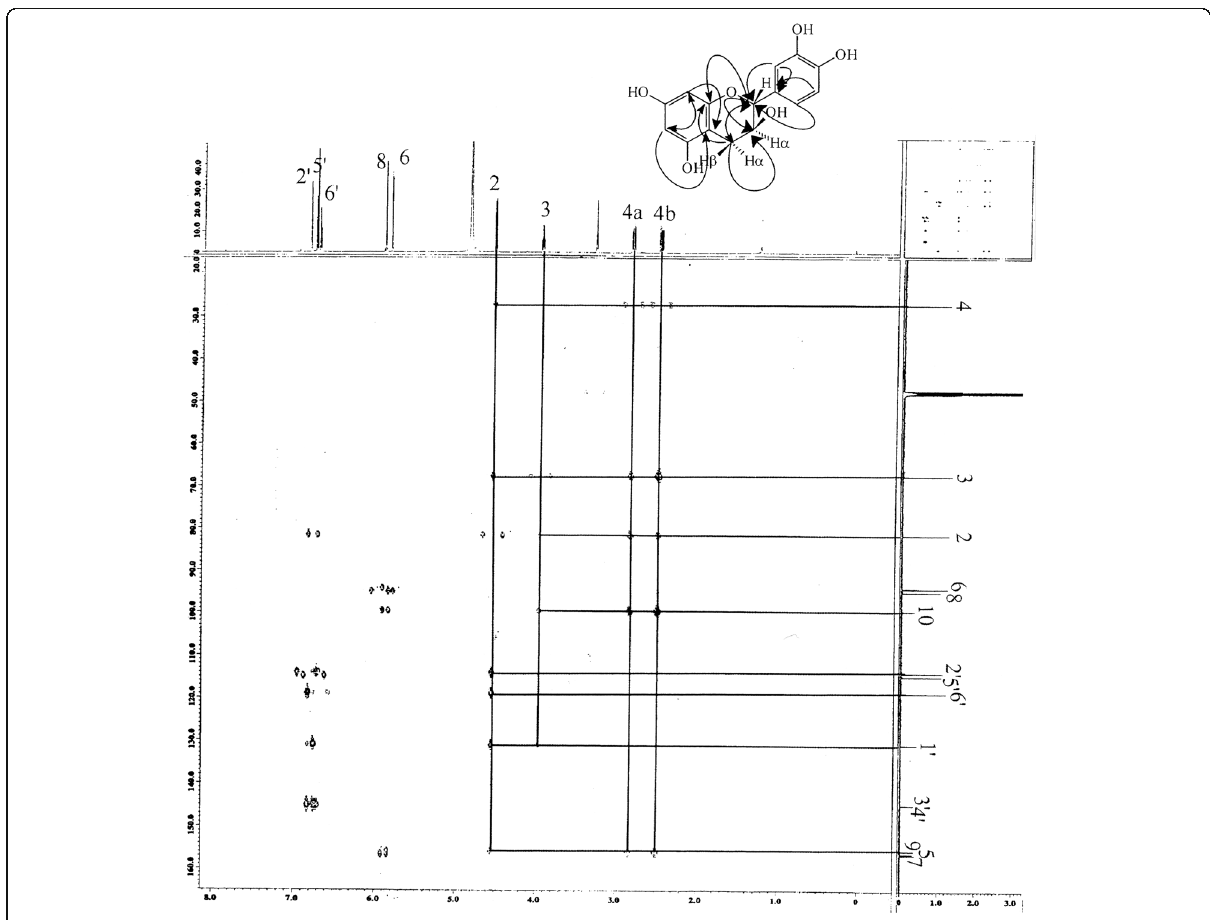
Fig. 1 HMBC spectrums of (+, − )